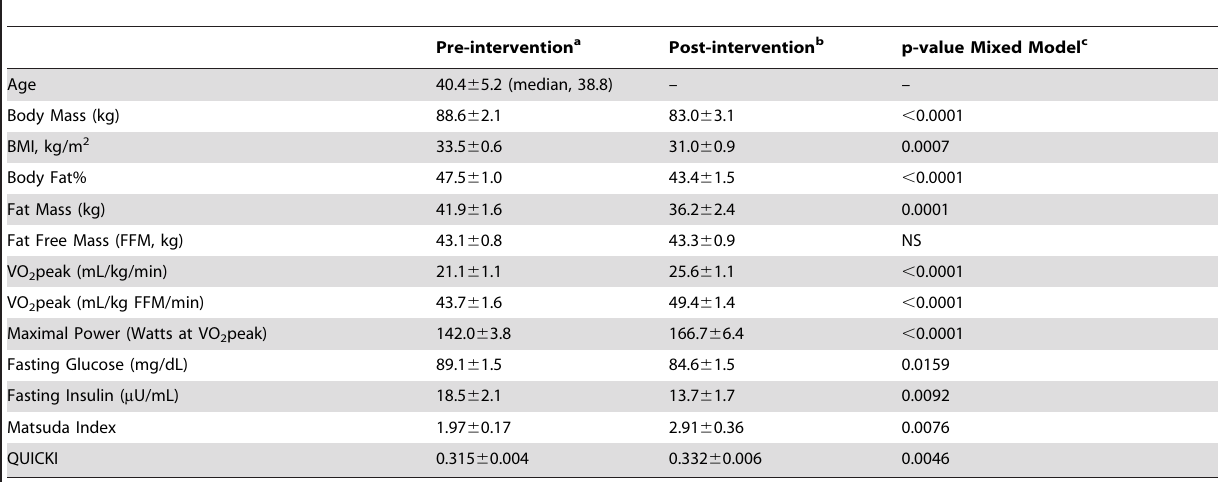
Table 1. Body mass, fitness, and glucose homeostasis indices in previously sedentary obese women following a weight loss and fitness